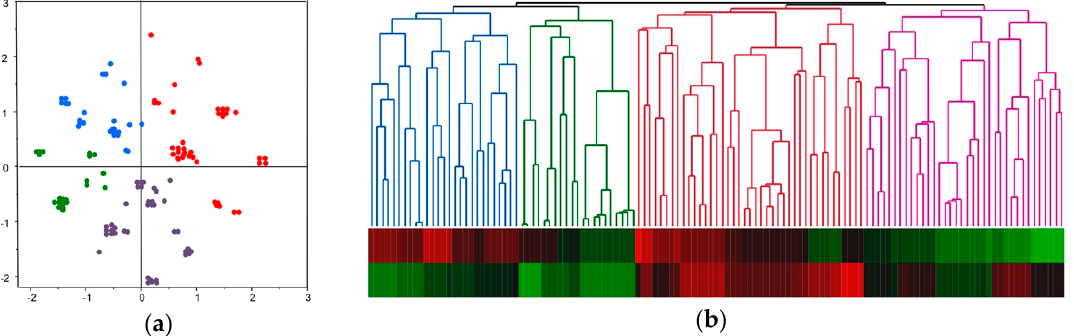
Figure 1. Molecular classification of HCC based on corresponding and hierarchical clustering analyses. Members of the A1-subclass are shown in blue, A2-subclass in green, B1-subclass in red, and B2-subclass in purple. ( a ) 125 HCCs were analyzed using the corresponding analysis based on the presence or absence or the CTNNB1 , TP53 , and TERT promoter mutations, methylation status on 8 TSG promoters (with or without hypermethylation), methylation status on the 3 kinds of rDNAs (with or without significant hypomethylation), and FAL score (<21% and ≥ 21%). ( b ) Hierarchical clustering analyses using x- and y-axis values of two-dimensional drawings of corresponding analysis shown in ( a ). Each subclass was determined based on the clusters.